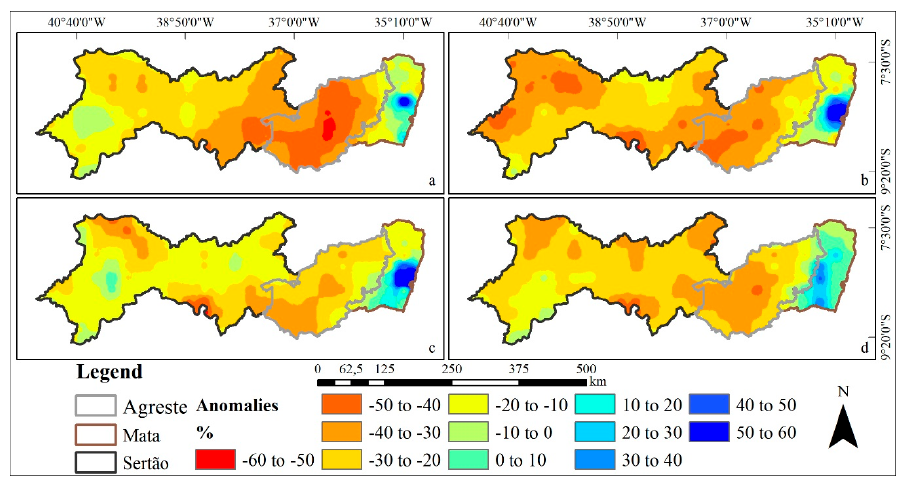
Figure 9. Soil moisture anomaly in 2012–2017 compared to 2010–2011 for the ( a ) JFM, ( b ) AMJ, ( c ) JAS, and ( d ) OND seasons. Remote Sens. 2018 , 10 , x FOR PEER REVIEW